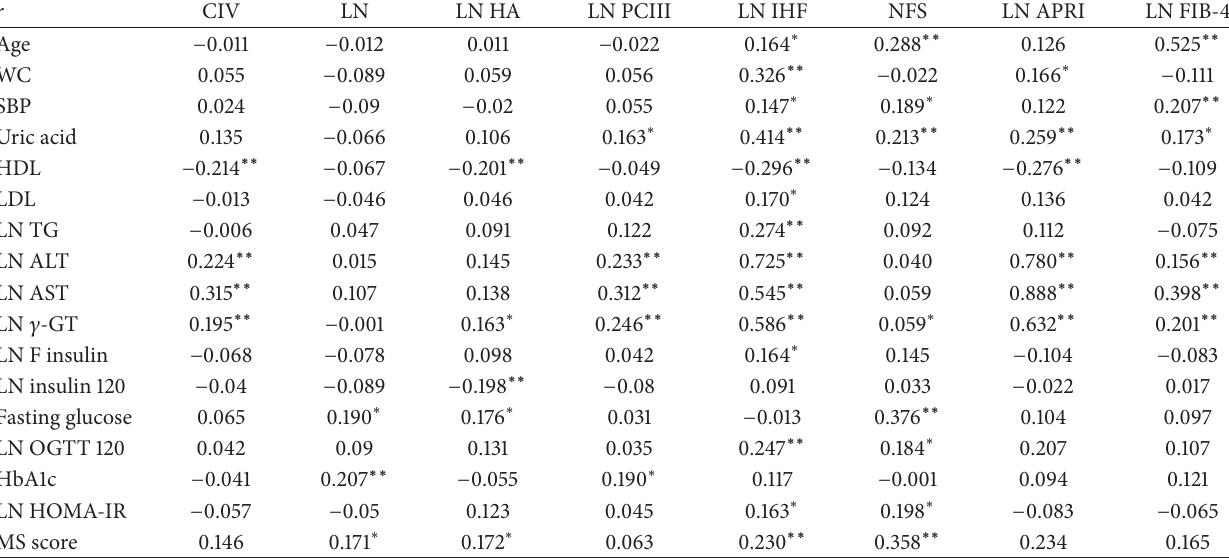
Table 3: Relationship between hepatic fibrosis markers, IHF, and biochemical